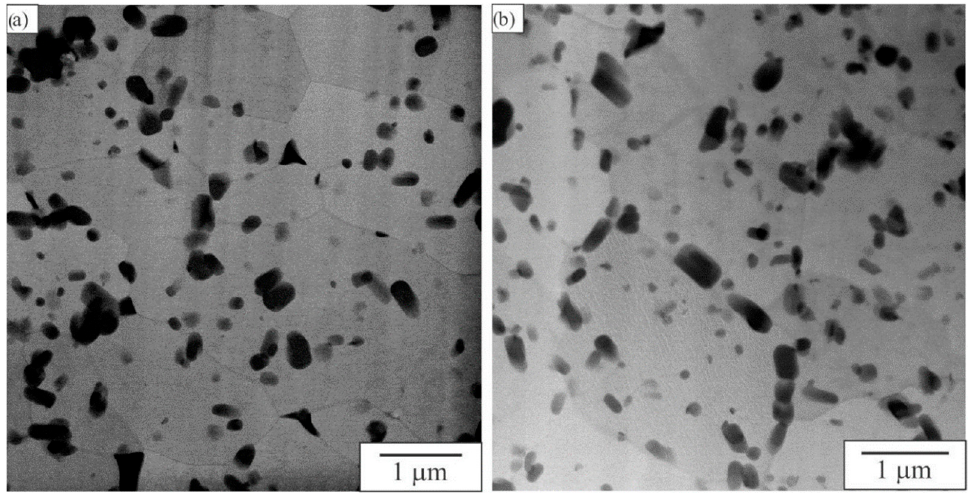
Figure 8. Bright-field transmission electron micrographs of sample FSP950. ( a ) stir zone, region NZ